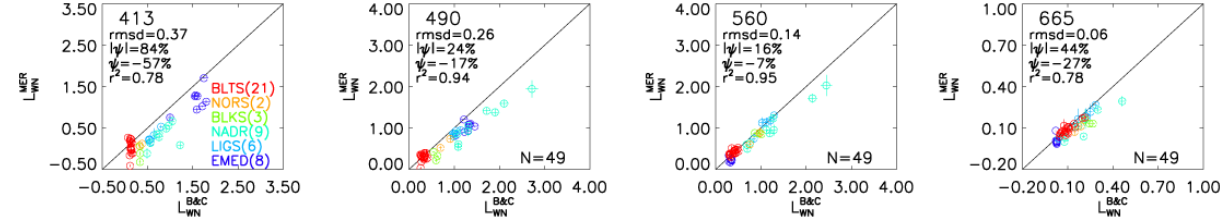
Fig. 4. Scatter plots of MERIS (MER) versus BiOMaP and CoASTS (B&C) L WN match-ups at selected center wavelengths determined with 1t =± 4h. Symbols and units are the same as in Fig. 1. Different colors identify match-ups from different seas: Baltic Sea (BLTS), North Sea (NORS), Black Sea (BLKS), northern Adriatic Sea (NADR), Ligurian Sea (LIGS), and Eastern Mediterranean Sea (EMED).